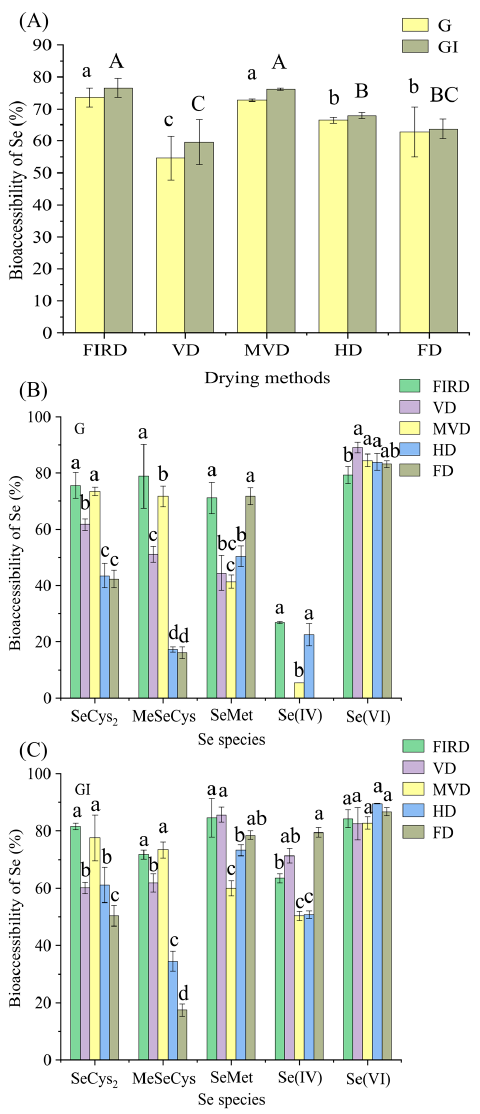
Figure 2. The bioaccessibility of Se ( A ) and Se species ( B , C ) in dried CVLs. Different letters represent significant differences ( p < 0.05). Different Se species groups were subjected to one-way ANOVA in B and C. G: gastric digestion stage; GI: gastrointestinal digestion stage. FIRD: CVLs of far-infrared drying; VD: CVLs of vacuum drying; MVD: CVLs of microwave vacuum drying; HD: CVLs of hot air drying; FD: CVLs of